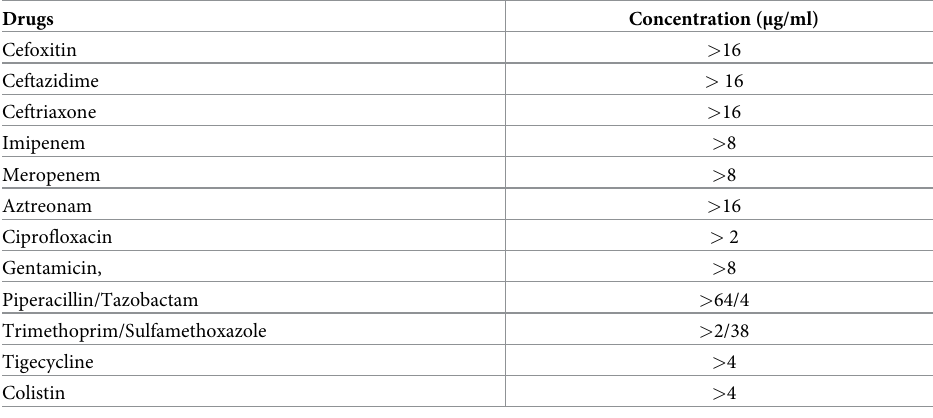
Table 1. Antibiotic sensitivity of A . baumannii strain